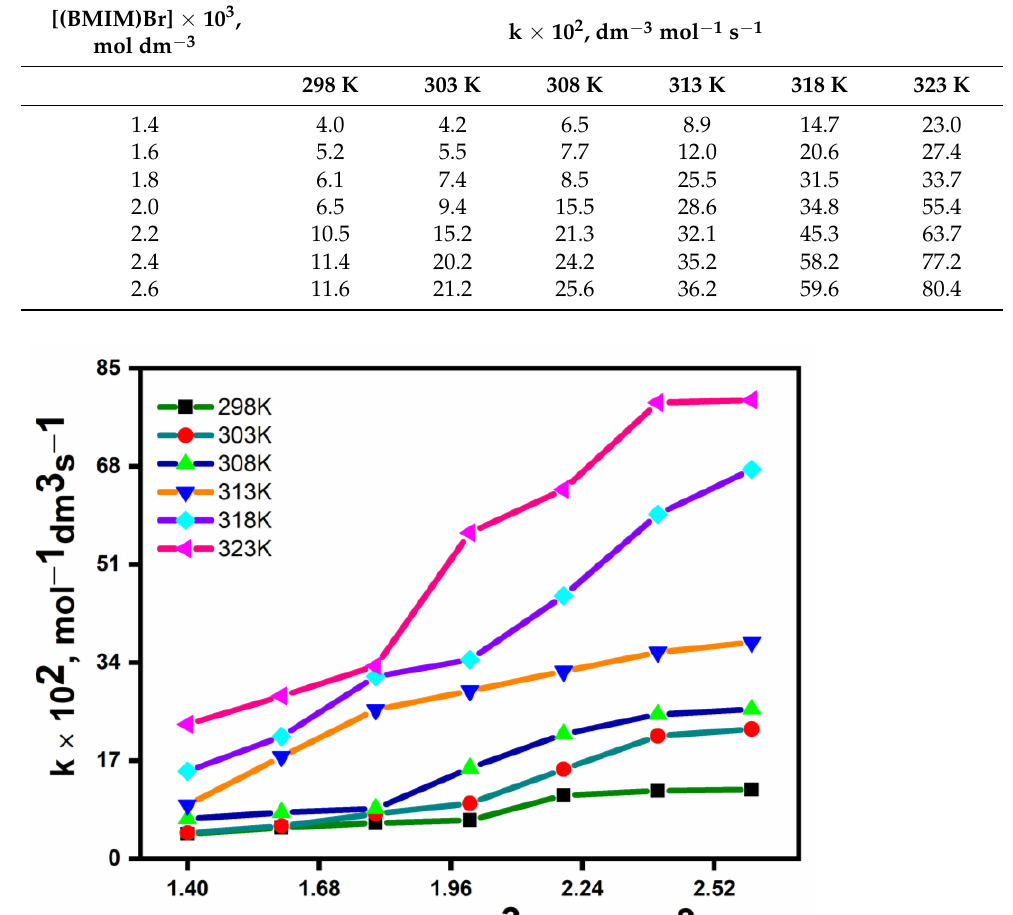
Table 2. Second-order rate constants for the reduction of cobalt(III) complex ion by Fe 2+ in the presence of [BMIM]Br under various temperatures; cis-[Co(ip) 2 (C 12 H 25 NH 2 ) 2 ](ClO 4 ) 3 = 4 × 10 − 4 mol dm − 3 ,